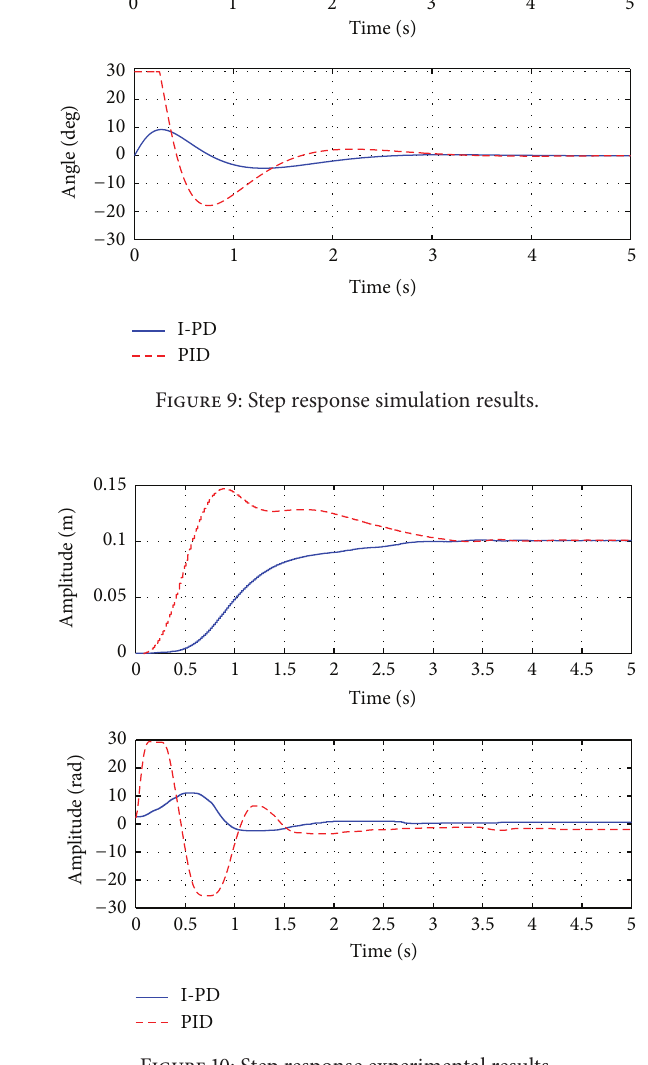
Figure 10: Step response experimental